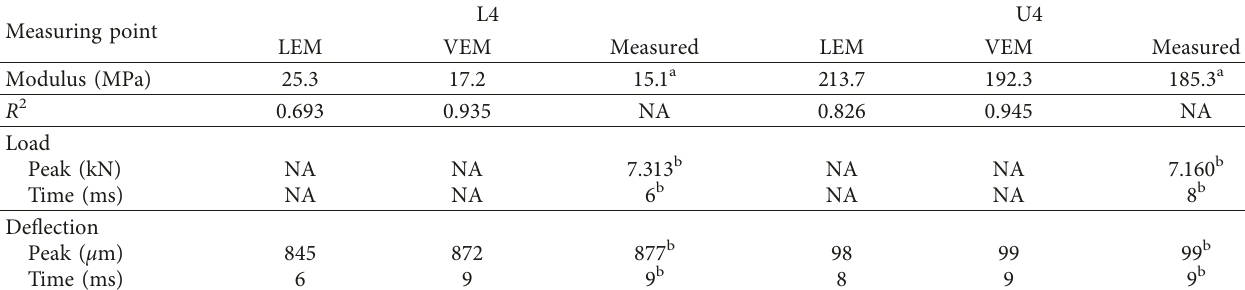
Table 1: Comparison of the LEM, VEM, and measured